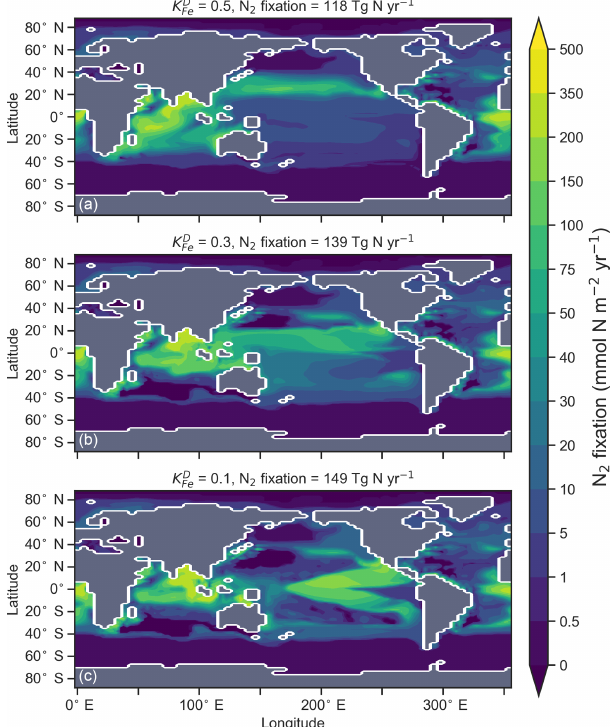
Figure 15. Changes in the distribution of marine N 2 fixation caused by altering how limiting iron is to the growth of N 2 fixers via the co- efficient K D Fe in Eq. (A12). Iron limitation is sequentially relaxed from top to